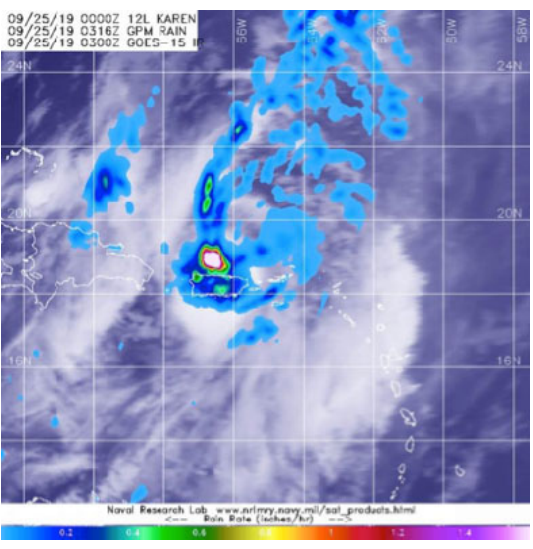
Figure 6. Tropical Storm Karen [30].